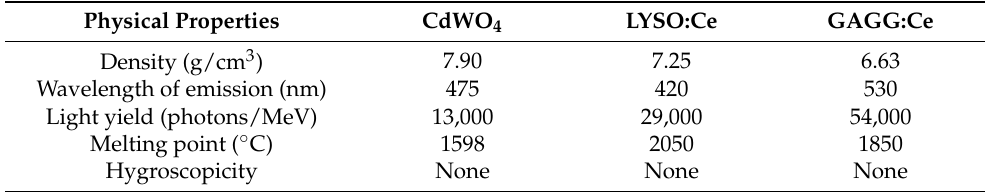
Table 1. Physical properties of the employed inorganic scintillators whose dimension was 3 × 3 × 20 mm 3 .